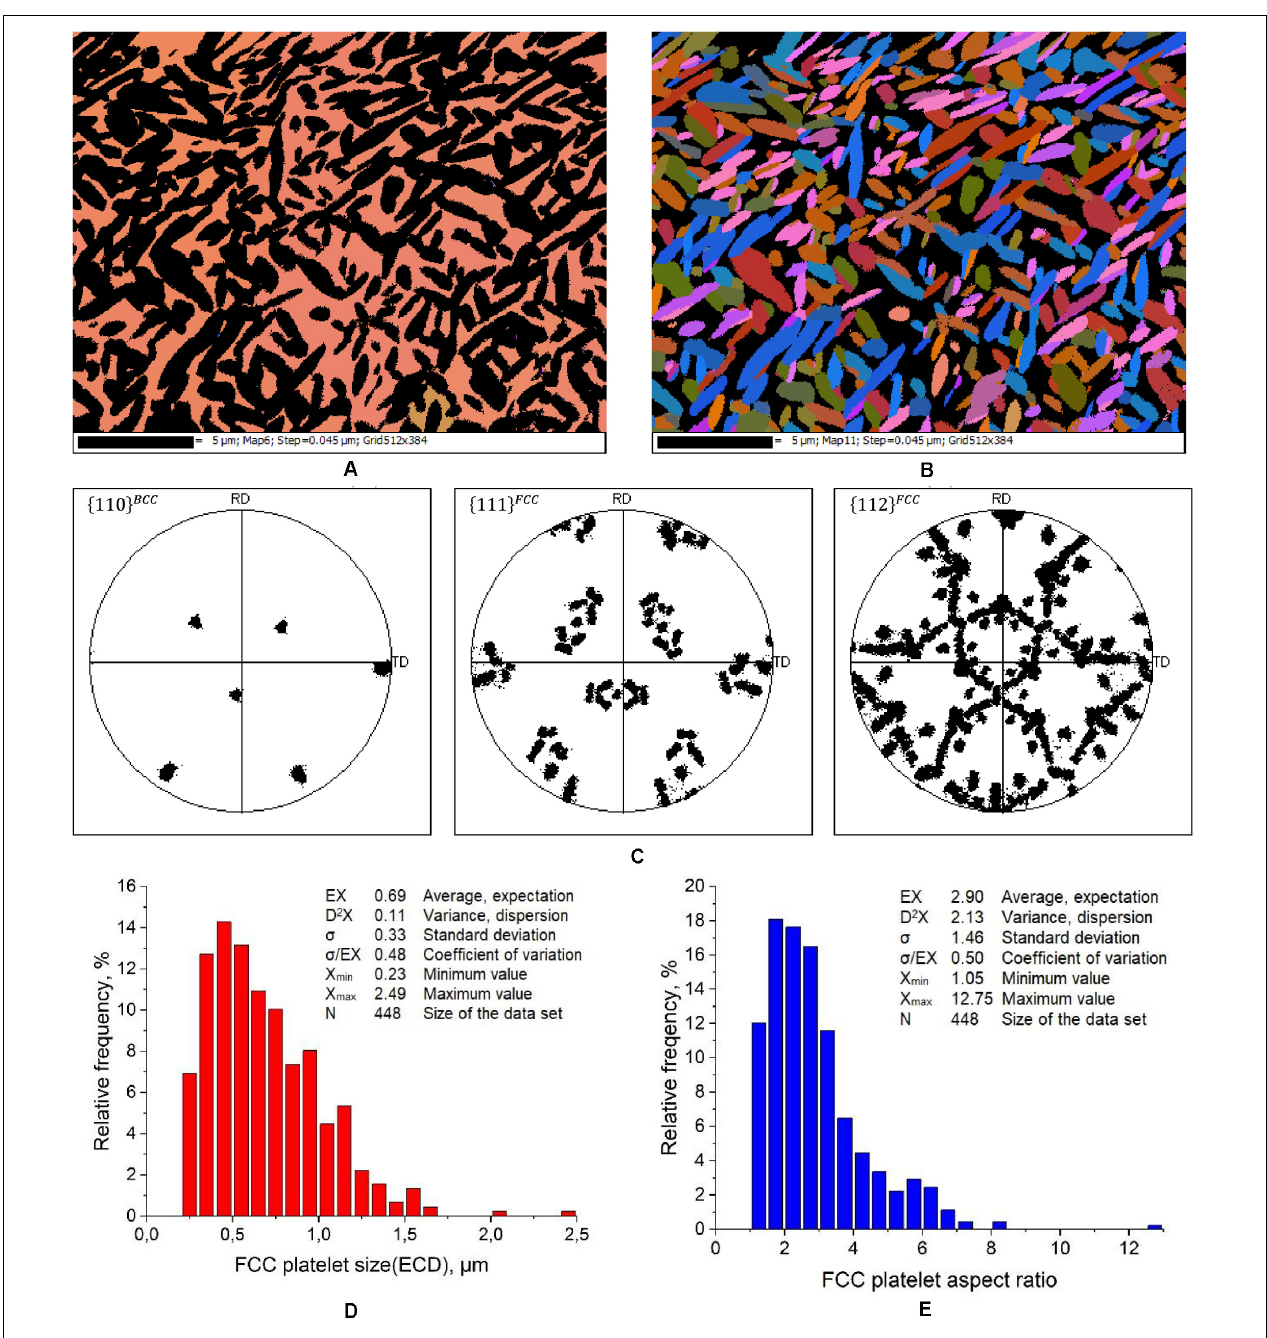
FIGURE 8 | OR in the AlCrFe 2 Ni 2 950 ◦ C-6 h heat treated coupon. Euler maps of the (A) BCC phase and (B) FCC phase showing the varied orientations of the FCC microplatelets. (C) The {110} BCC, {111}, and {112} FCC pole figures with the obtained N–W variants. (D) The FCC microplatelet size, and (E) aspect ratio